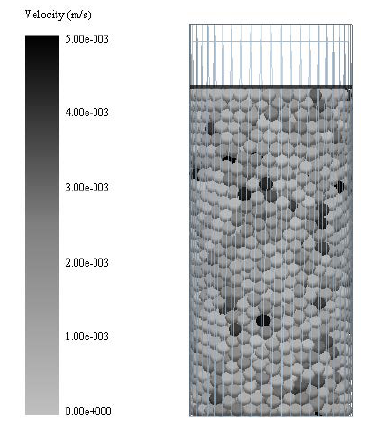
Fig. 2-3 Schematic diagram of particle velocity of uniaxial compression